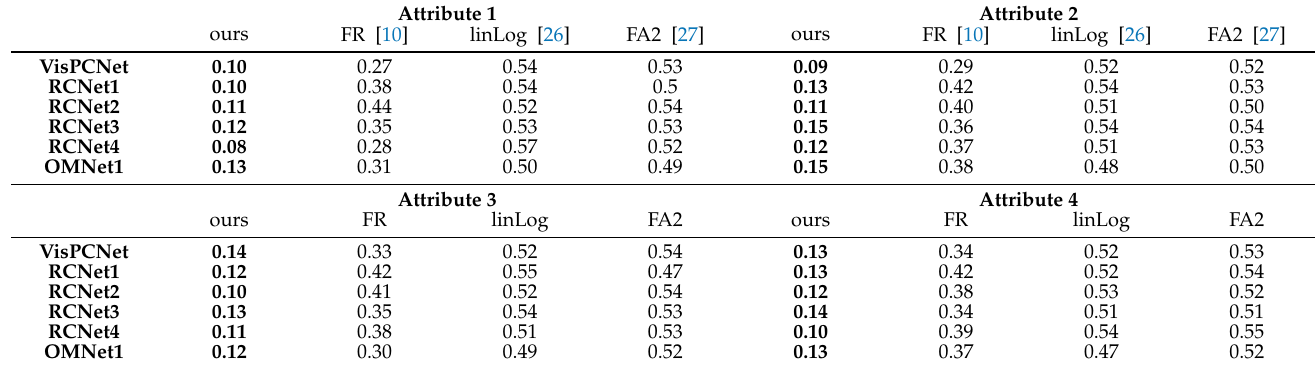
Table 2. Average distance between nodes in attribute community.